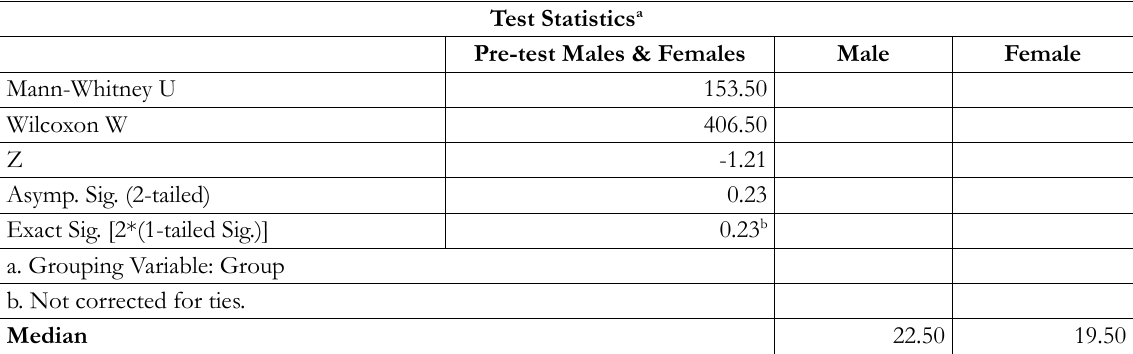
Table 5. A Mann Whitney U-test on the males and females’ pre-test performance in EG.